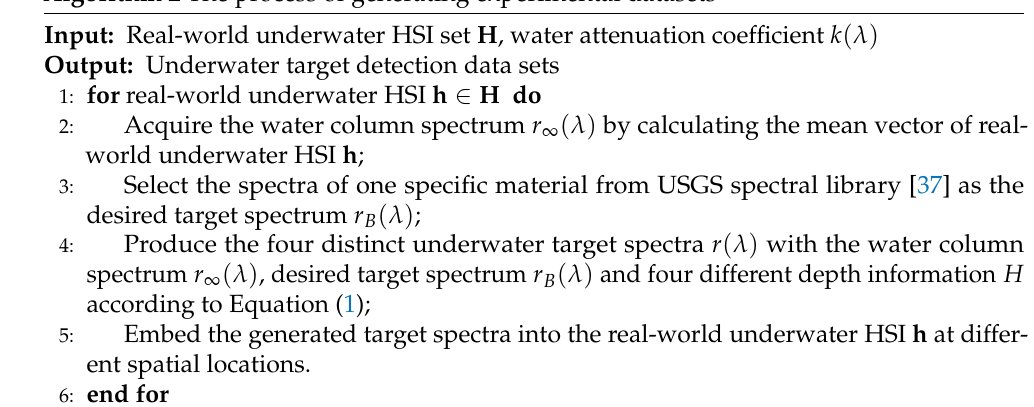
Algorithm 2 The process of generating experimental